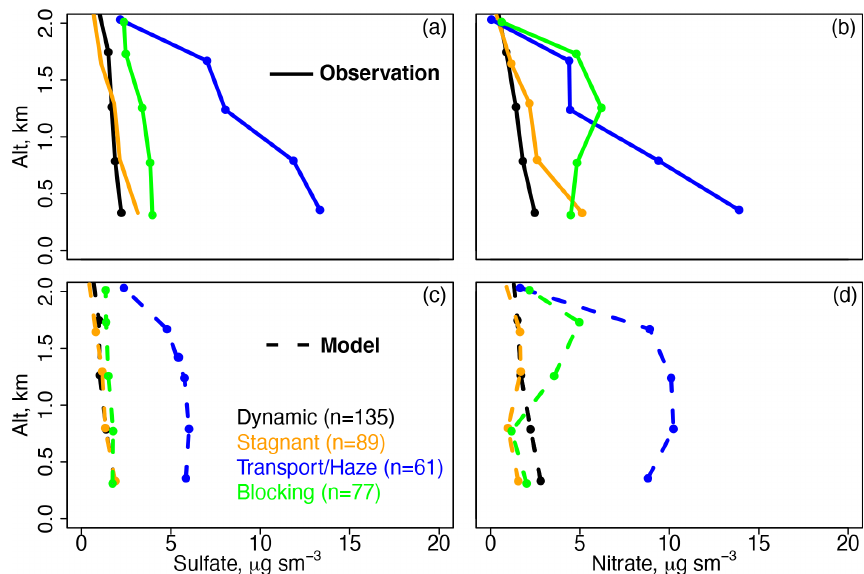
Figure 3. Mean vertical profiles of (a) observed sulfate, (b) observed nitrate, (c) model sulfate, and (d) model nitrate for the descents over Olympic Park for each meteorological period. The observations (solid lines) and model (dashed lines) are binned to the nearest 0.5km below